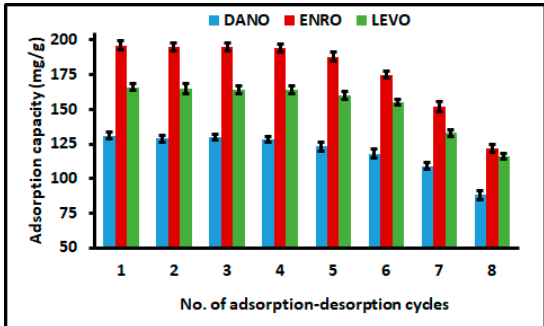
Figure 9. Regeneration of MMC / Cyc-Chit nanocomposite for eight successive adsorption–desorption cycles. Experimental conditions: C 0 = 50 mg L − 1 ; extraction time = 180 min; pH = 3.0; mass adsorbent = 36 mg; desorption solvent: acidified water and acetonitrile mixture (55:45 ratio); desorption time = 10